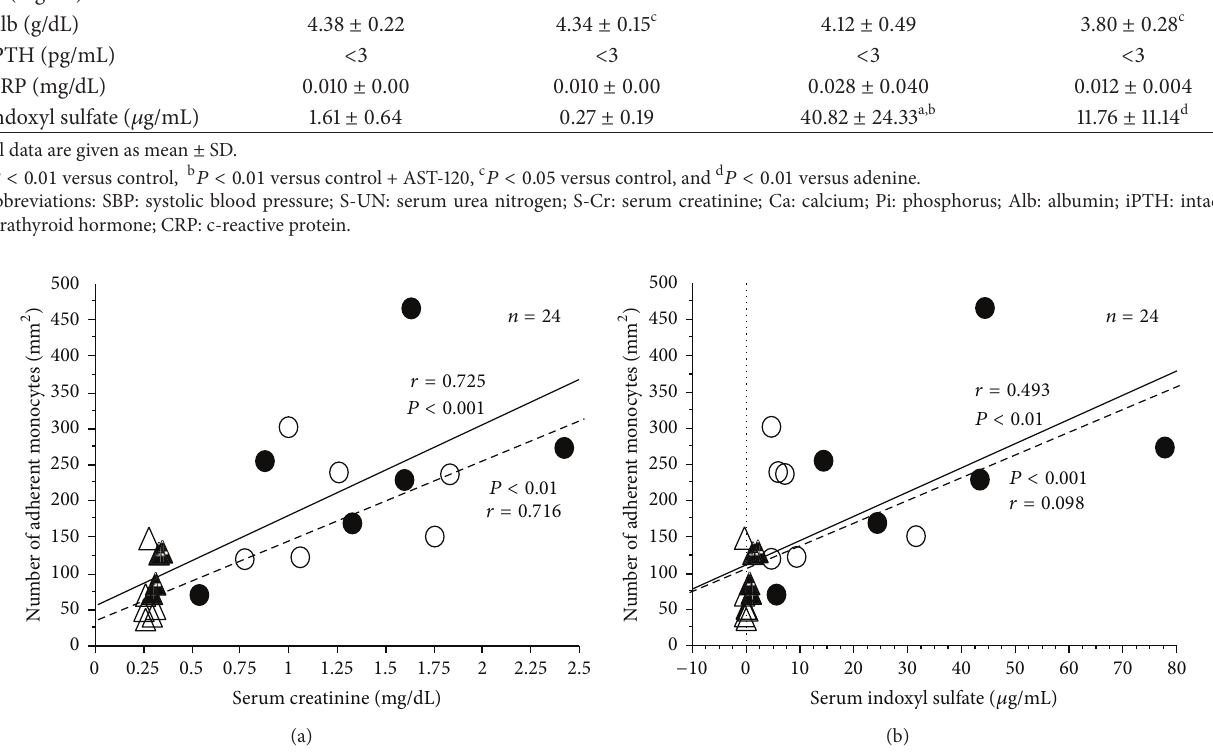
Figure 3: Relationship between the number of monocytes adherent to endothelial cells and the level of serum creatinine (Cr) and indoxyl sulfate (IS). Closed circles: adenine alone; open circles: adenine + AST-120; closed triangles: control; open triangles: control + AST-120. Solid line: the control and the adenine rats ( 𝑛 = 12 ); dotted line: the control + AST-120 and the adenine + AST-120 rats ( 𝑛 = 12